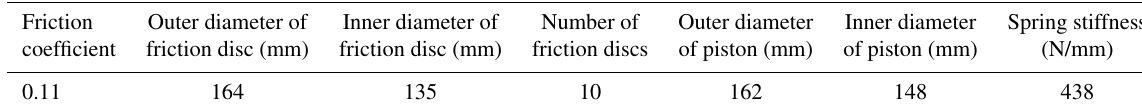
Table 5. Parameters of wet clutch WF012.